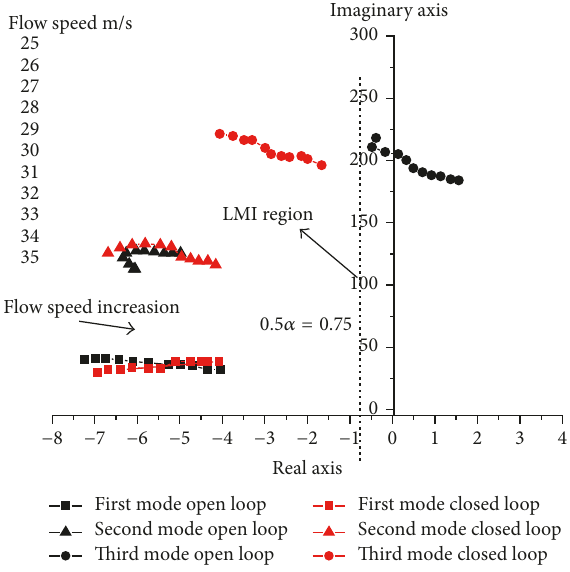
Figure 16: Switching control test